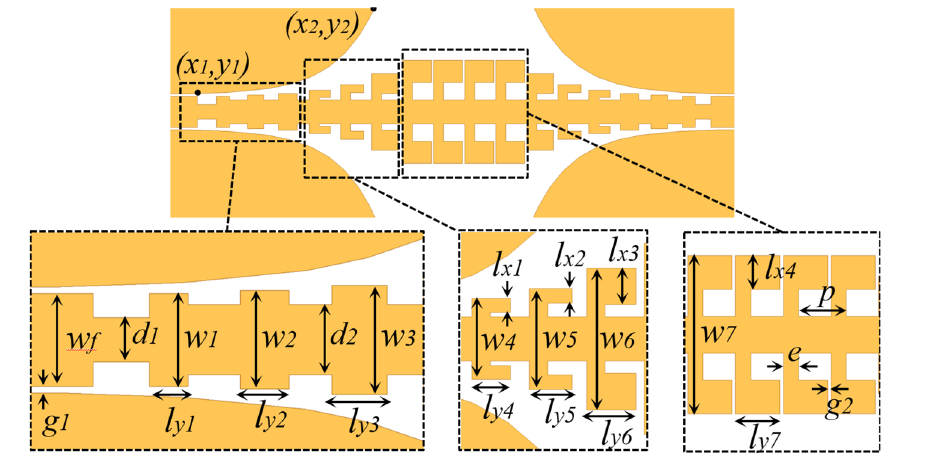
Figure 3. Schematic picture of the proposed transition with gradient L-shaped grooves and two flaring grounds. Detailed dimensions are determined as := w 1 = 0.715, w 2 = 0.76, w 3 = 0.84, w 4 = 1, w 5 = 1.24, w 6 = 1.74, w 7 = 2.34, l y 1 = 0.3, l y 2 = 0.38, l y 3 = 0.42, l y 4 = 0.5, l y 5 = 0.52, l y 6 = 0.6, l y 7 = 0.65, l x 1 = 0.17, l x 2 = 0.18, l x 3 = 0.45, l x 4 = 0.5, d = 0.34, d 2 = 0.54, = 0.05, p = 0.7, e = 0.22 (all dimensions are in mm ). CST microwave studio 2020 (https:// www. 3ds. com/ g 2 produ cts- servi ces/ simul ia/ produ cts/ cst- studio- suite/) was used to generate this